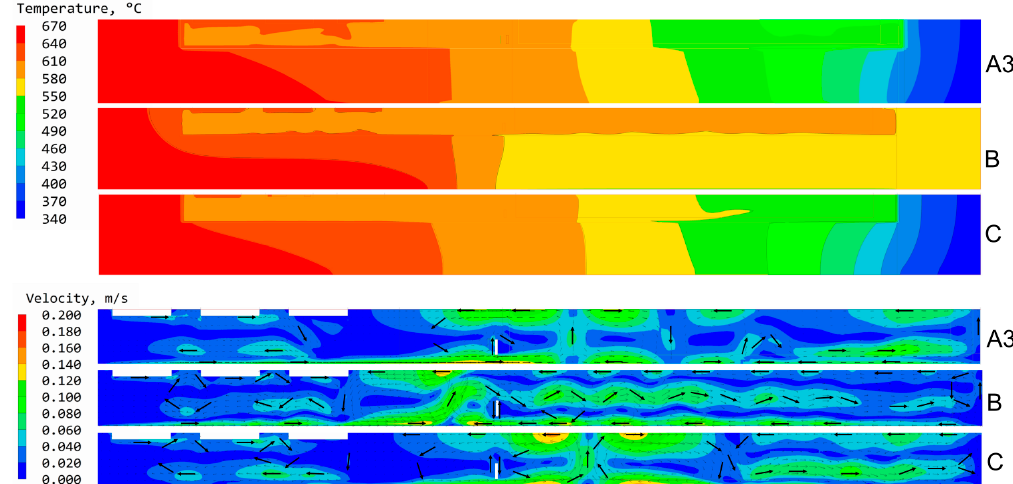
Figure 13. Temperature distributions (top) and flow fields (bottom) for case type A (including furnace and surrounding), B (heater-long fixed temperature), and type C (i.e., using the outer wall temperature distribution extracted from the corresponding furnace-including simulation A3). The plots of the velocity fields have been changed in aspect ratio to improve readability of the figure, and the figures are rotated with respect to gravity (bottom of the autoclave is on the left side of the figure). For better visibility, thick arrows were added as guides to the eye.